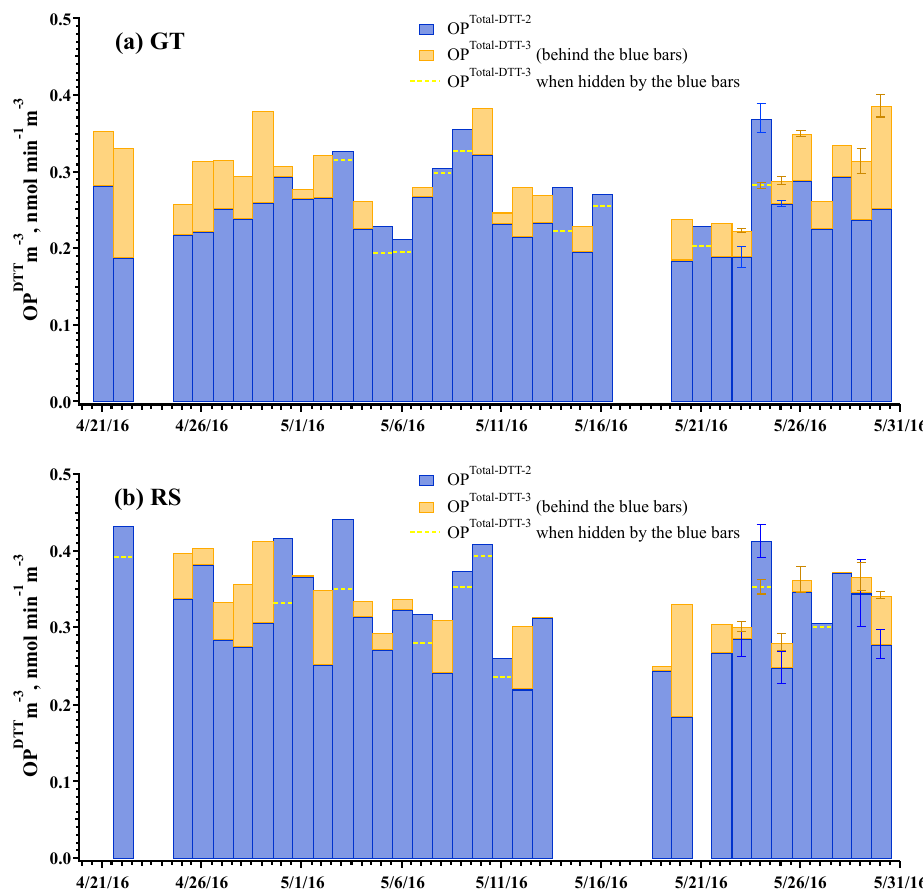
Figure 6. Comparison of OP DTT m − 3 between methods 2 and 3 at (a) GT ( N = 35) and (b) RS ( N = 31). Error bars denote 1 standard deviation in OP DTT m − 3 from repeated